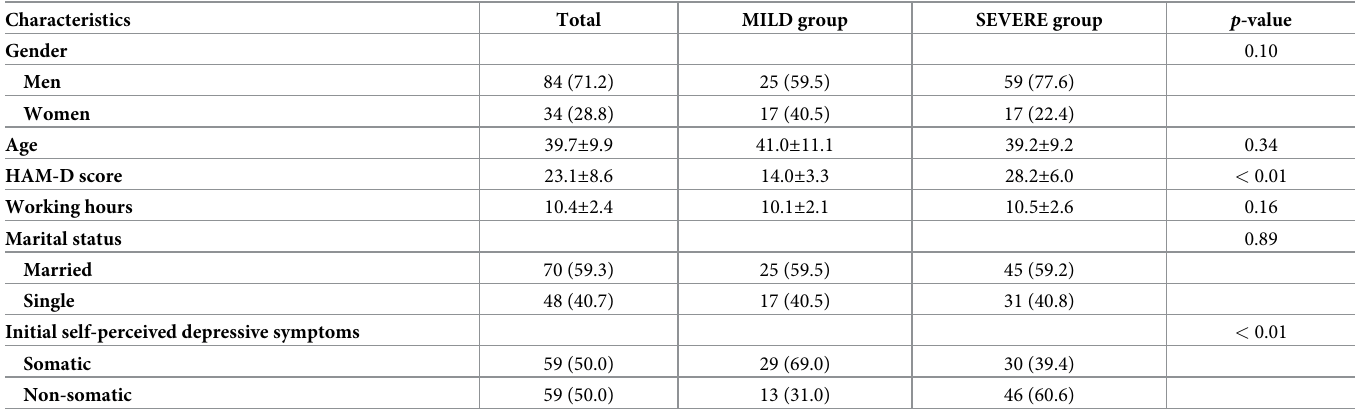
Table 1. Demographic characteristics of the participants (N = 118).